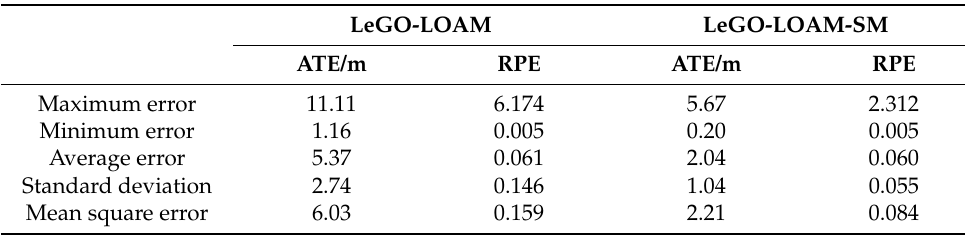
Table 2. ATE and RPE of KITTI dataset 00 sequence estimated by LeGO-LOAM-SM and LeGO-LOAM.